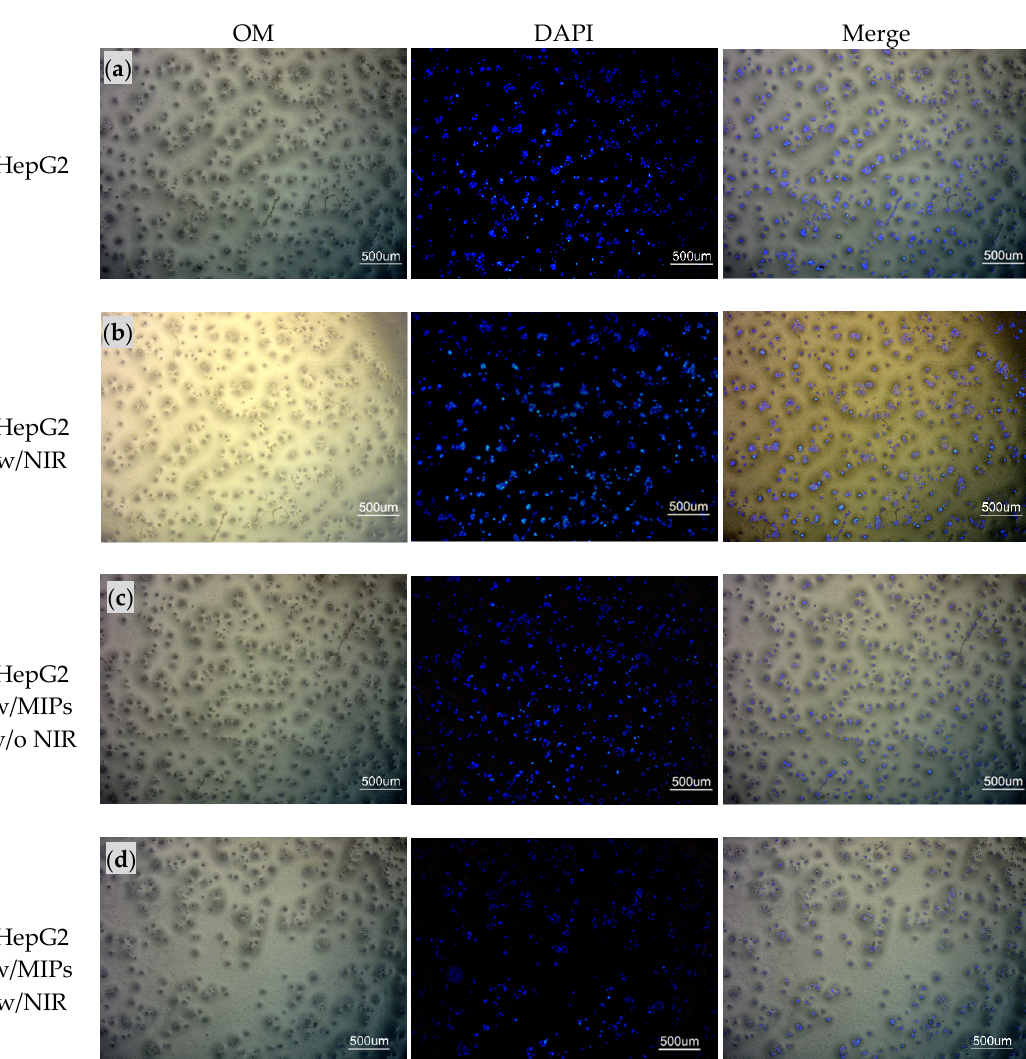
Figure 4. Optical, DAPI-stained, and merged images (from left to right columns) of ( a , b ) HepG2 cells ( c , d ) with MIPs under ( b , d ) irradiation or ( a , c ) not.